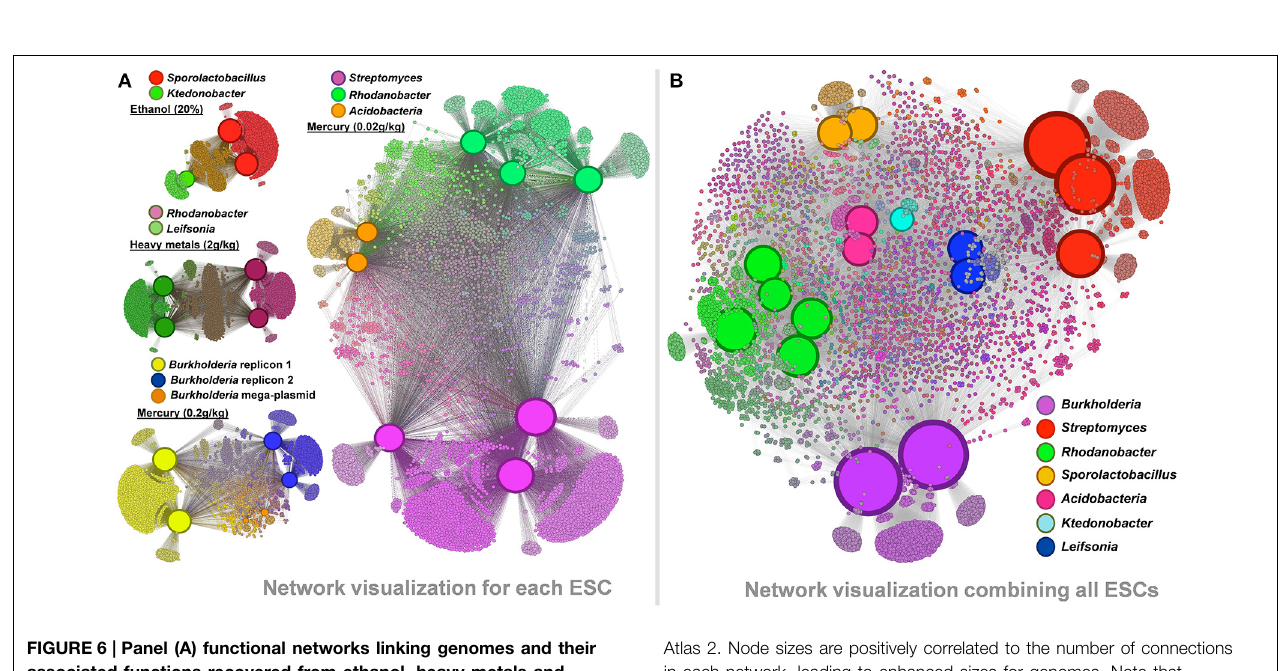
on the data. Draft genomes are displayed in the outer cycle and the tree itself. Note that coverage discrepancies observed (e.g., for Burlholderia Mer-3A in the mercury enrichment #1) do not necessarily reflect a binning problem, as metagenomic reads that would have mapped to other genetic structures have a restrained target choice of 8 draft genomes in this analysis.